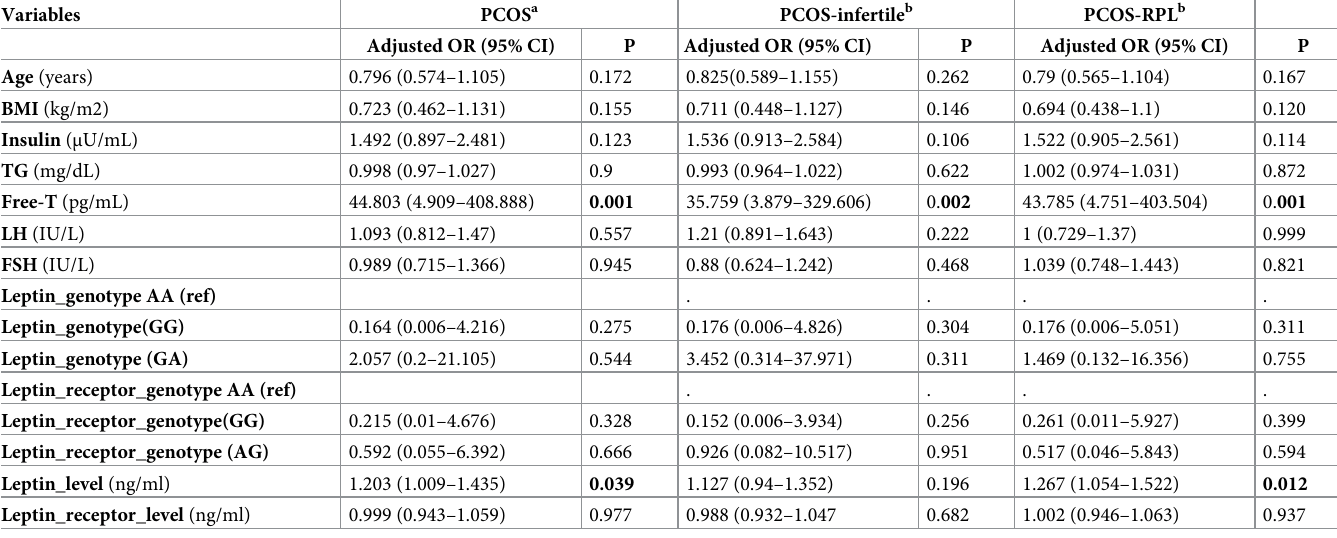
Table 3. LEP (rs7799039) and LEPR (rs1137101) polymorphisms and the risk of PCOS, PCOS-infertile, and